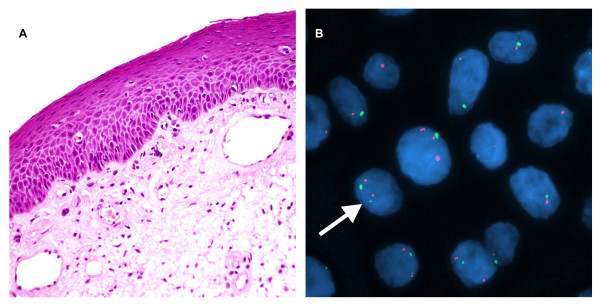
A case of normal epithelium of the larynx. A. H&E stain. (magnification, ×200). B. Interphase FISH displaying a normal signal pattern containing two copies (arrow) each of hTERC (red) and chromosome 3 centromere specific probe CSP3 (the internal control probe) (green), the CSP3: hTERC signal pattern is 2:2 (green:red). (×1000).